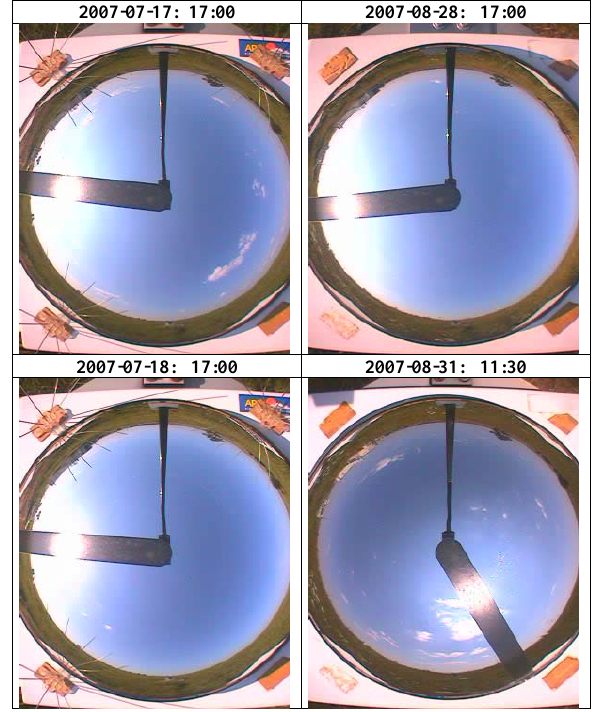
Fig. 3a . Hemispherical total sky images for the first 4 days in Fig. 2. The local time is included.